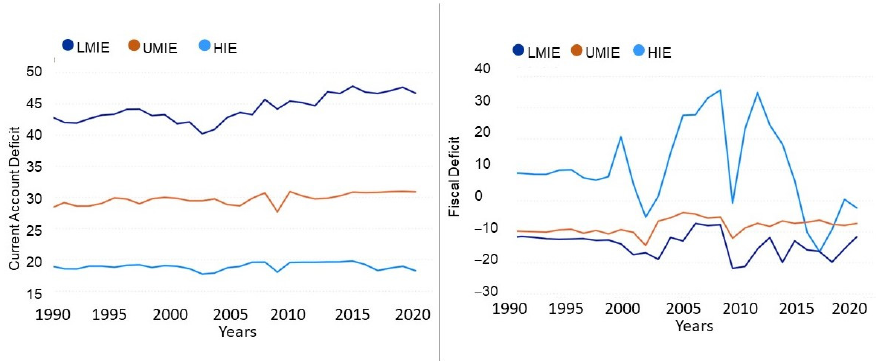
Figure 2. Fiscal and Current Account Deficits in ASEAN.